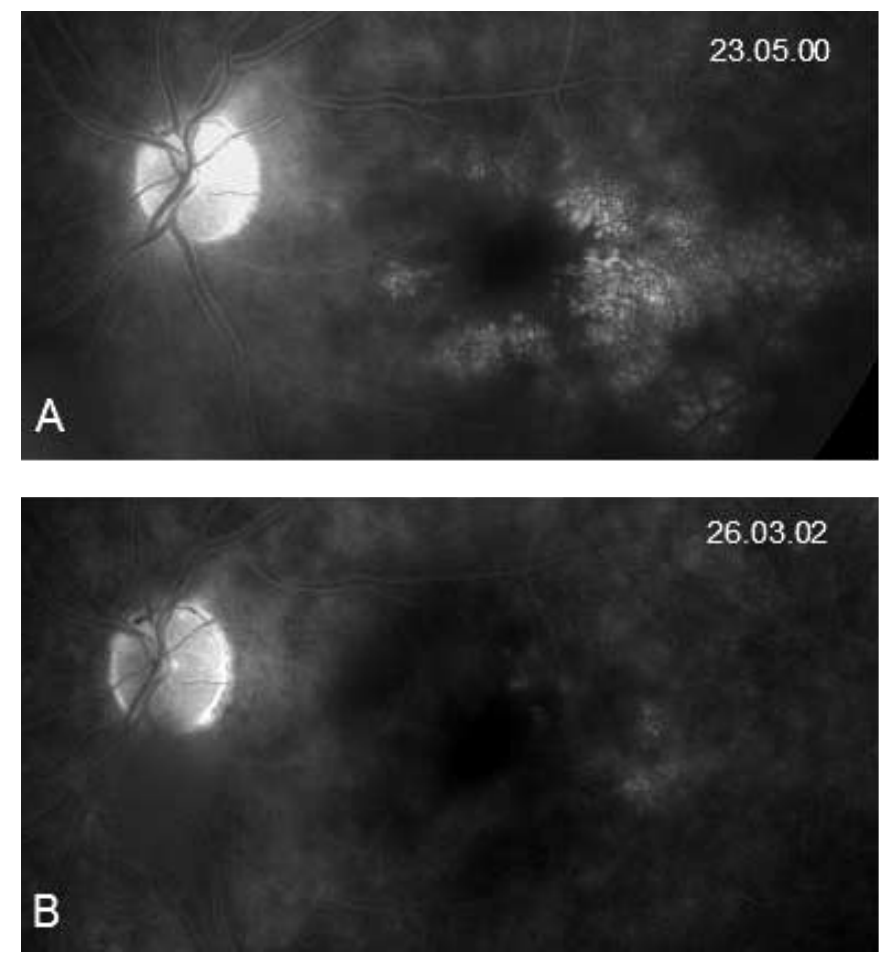
Behçet’s disease: Amount of retinal inflammatory fluores- cein leakage. A before, B after treatment with inflix- imab (5 mg/kg body- weight). Pictures were taken 8.6 min and 9.0 min after in- travenous fluorescein injection (late phase